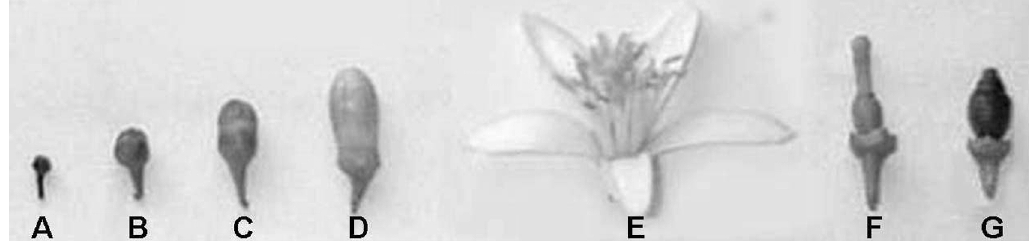
Fig. 2: Stages of flower bud development: (A) Bud having pollen mother cells before prophase of first meiotic division; (B) Bud during meiosis in anthers; (C) Bud at young pollen grain stage; (D) Bud nearly full-grown; (E) Flower at time of pollination; (F) Pistil just after fall of petals and stamens (about